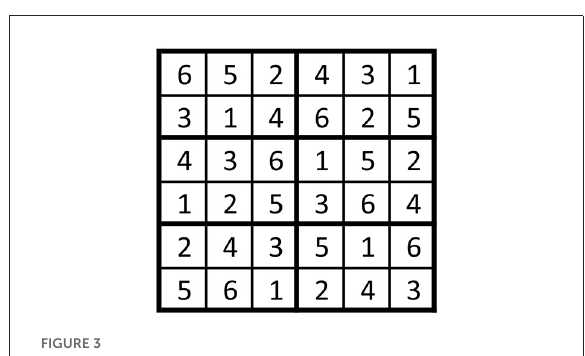
Sudokus were needed. In order to accommodate 12 participants, eight Sudokus were used in total in this experiment to make 12 rows for the 12